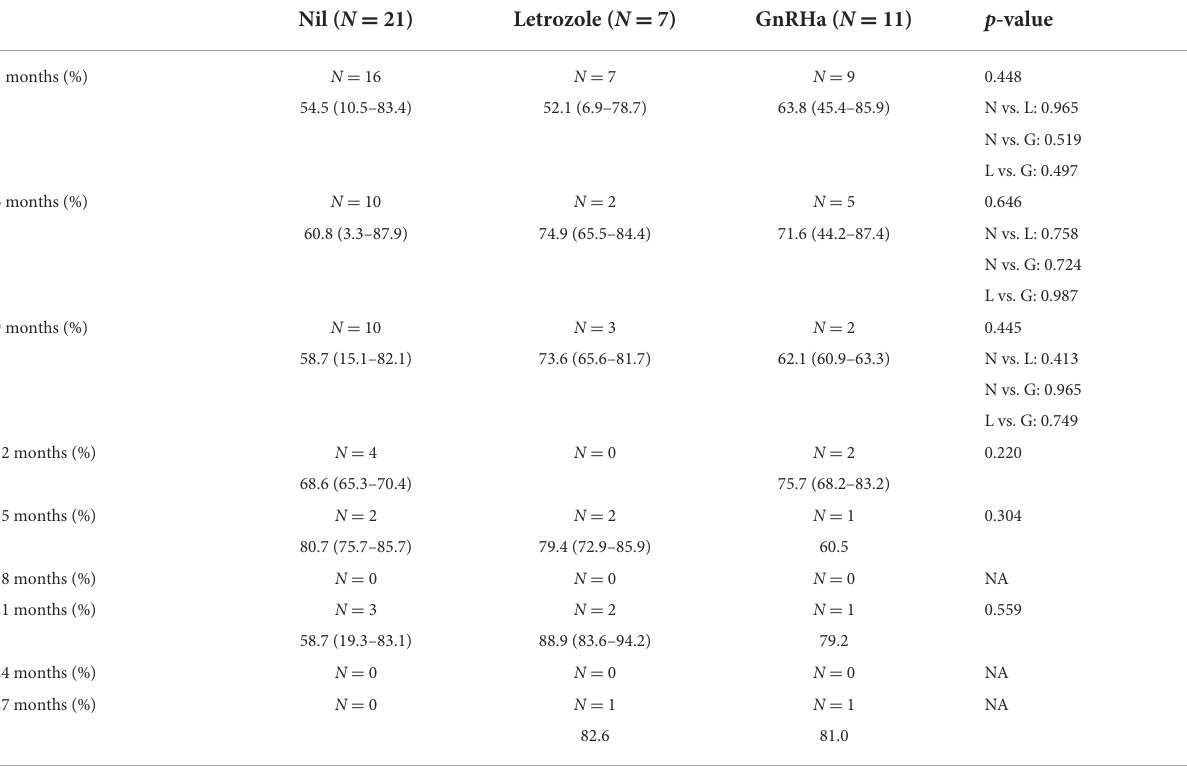
TABLE 4 Volume reduction rates of uterine fibroid after HIFU treatment at different follow-up